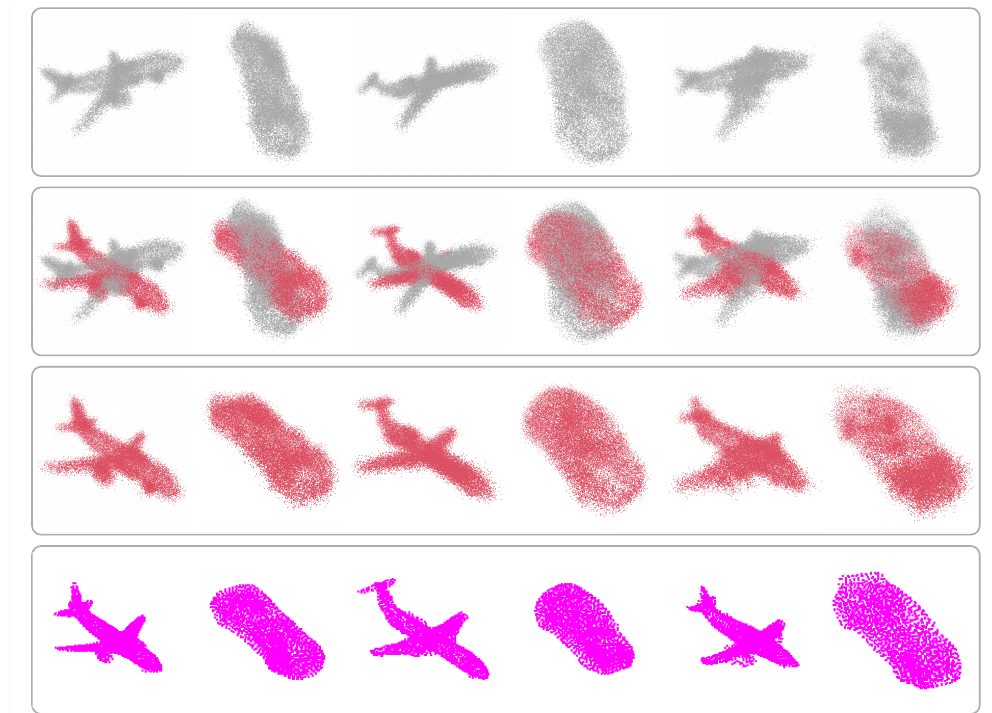
Figure 8. Sample results from experiments on CMD-Net dataset. Instances in the 1first row shows rotated noise-corrupted point clouds in the testing stage ( σ = 0.02). In the second and the third rows, CMD-Net canonicalizes test inputs, and the last row depicts denoised instances in the canonical space. Please compare this figure with Figure